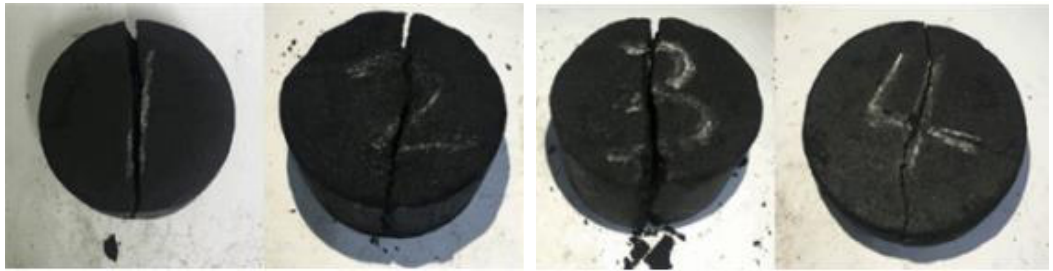
Figure 6. Splitting test specimen failure morphologies.